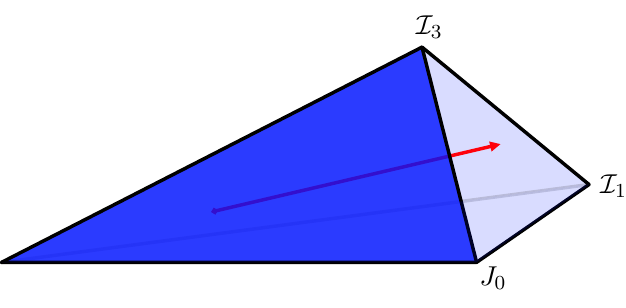
Figure 6 . Besides J 0 , the J -class A limits feature two other sets of K(cid:127)ahler cone generators, distinguished by their intersection properties with J 2